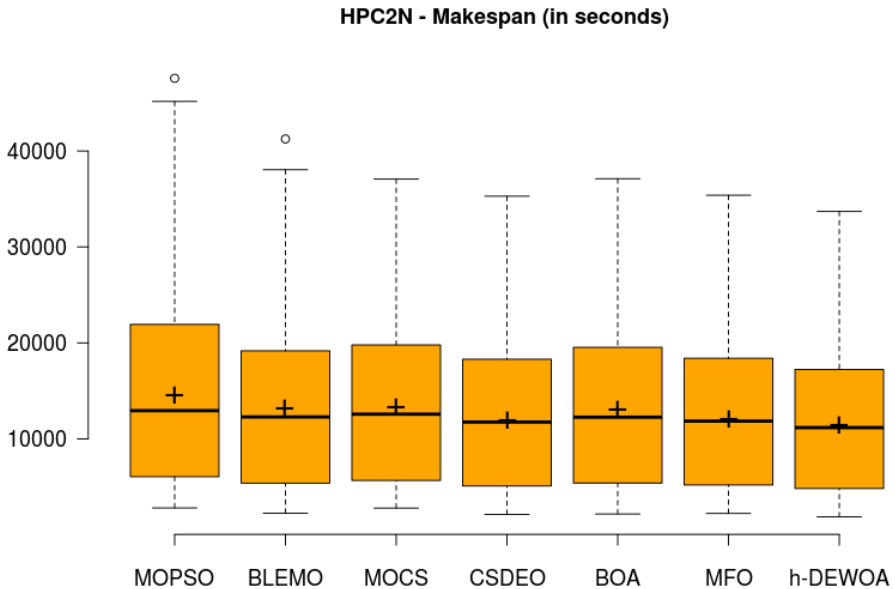
Figure 18. Comparative boxplot analysis of the overall makespan of h-DEWOA and recent state-of-the-art algorithms for HPC2N workloads.